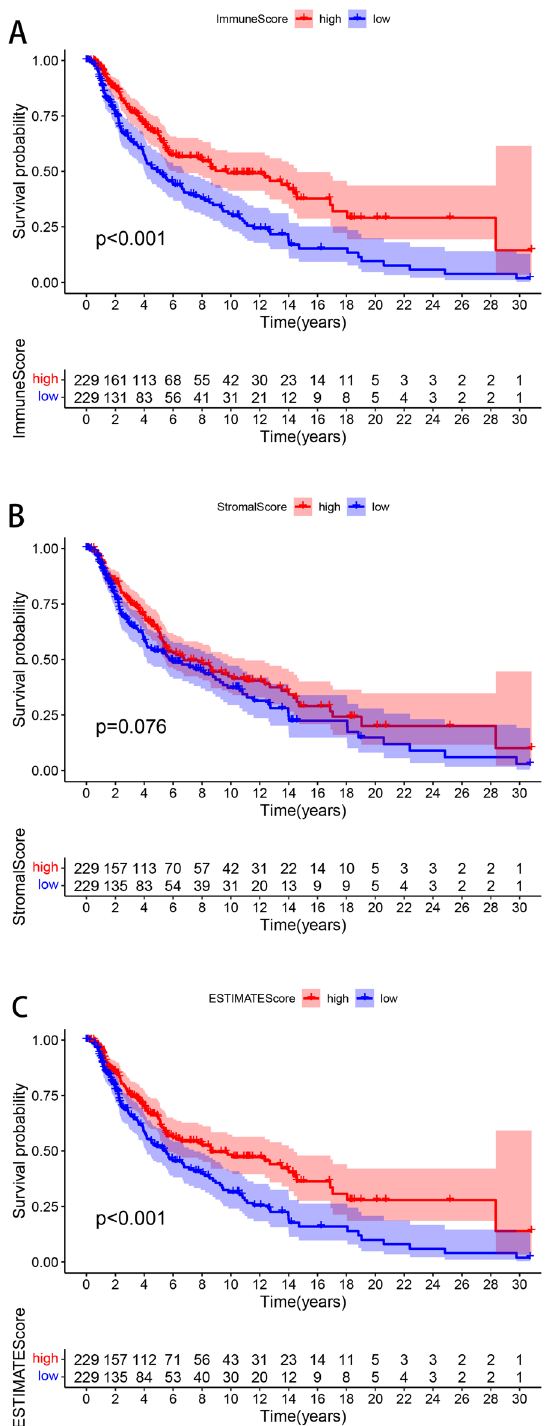
Figure 2. Associations of ImmuneScore, StromalScore, and ESTIMATEScore with survival among patients with SKCM. Kaplan–Meier survival analyses of patients with SKCM with low and high ( A ) ImmuneScores. ( B ) StromalScores. and ( C ) ESTIMATEScores. This figure was generated using “Survival” and “survminer” R